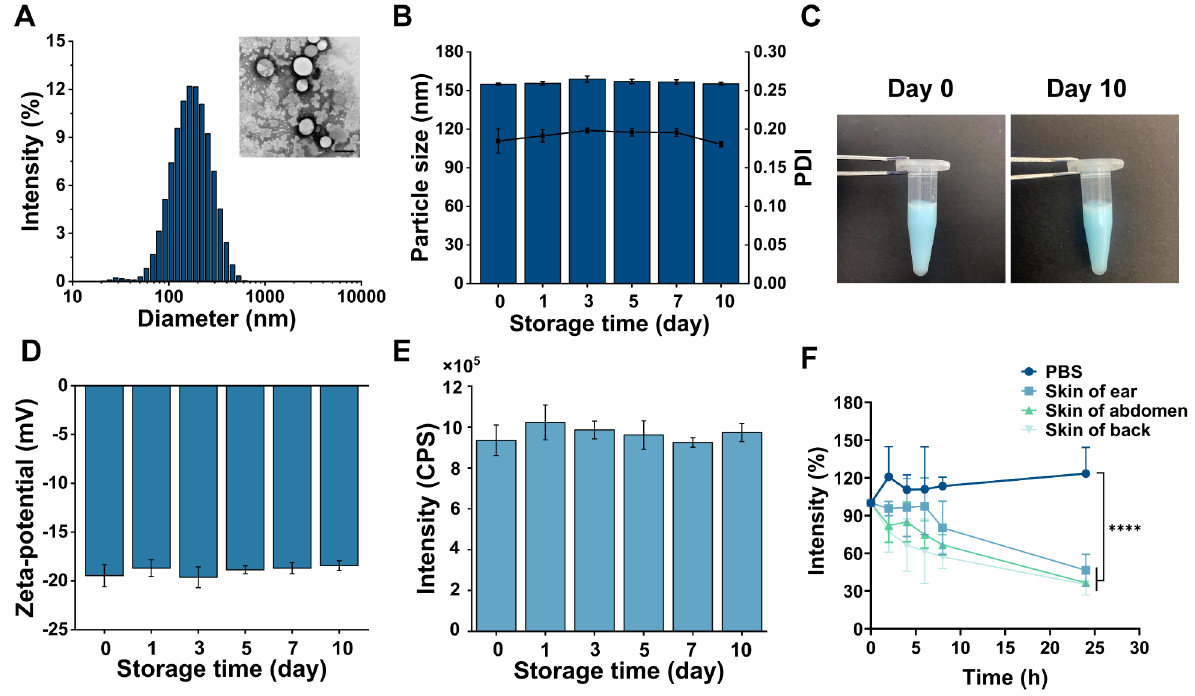
Figure 2. Preparation and characterization of P4 SLNs. ( A ) Particle size distribution and TEM image of P4 SLNs (scale bar: 200 nm). ( B ) Stability of the averaged particle size and PDI of P4 SLNs ( n = 3). ( C ) The appearance of P4 SLNs before and after ten days. ( D ) Stability of zeta potential of P4 SLNs ( n = 3). ( E ) Peak values of emission spectra of P4 SLNs over ten days ( n = 3). ( F ) Fluorescence quenching of P4 SLNs in biological matrices ( n = 3). Data are expressed as mean ± SD. Note: **** denotes p < 0.0001 vs group of PBS.